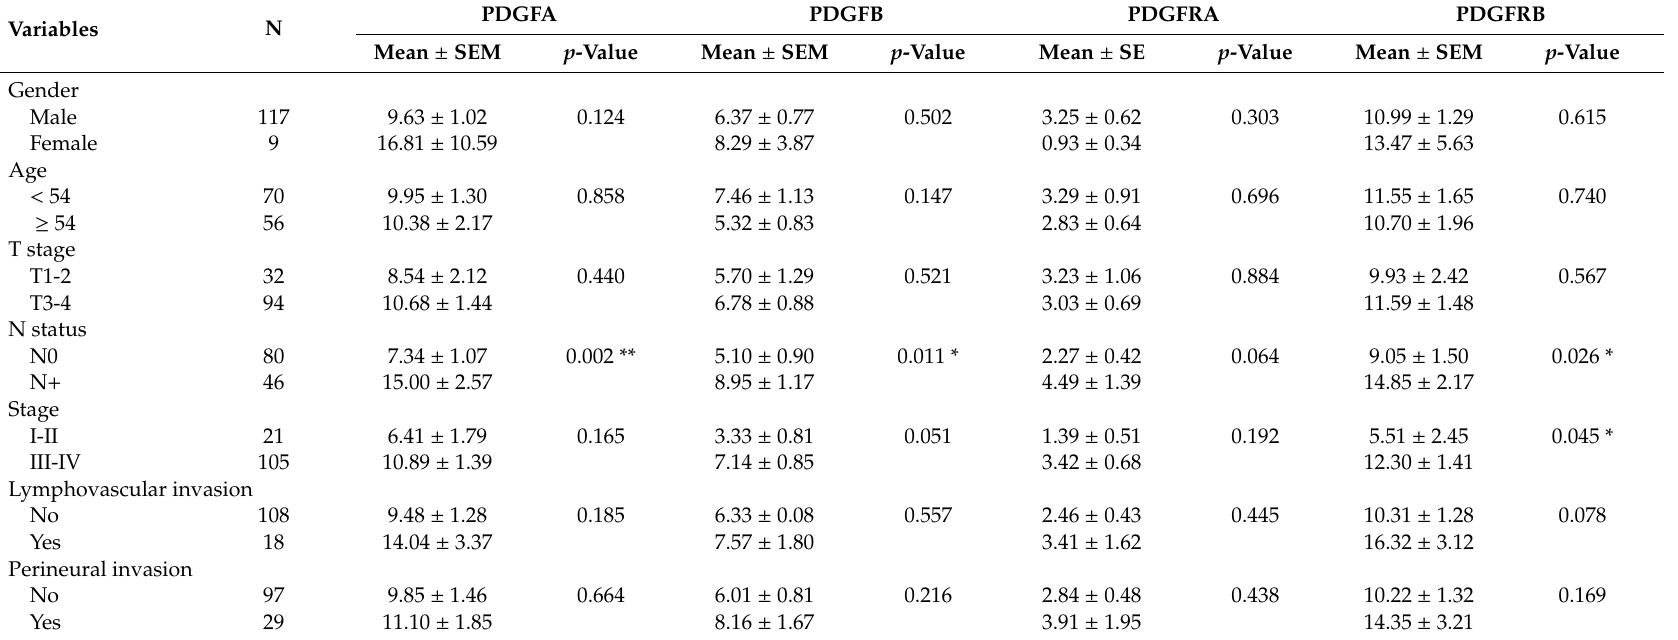
Table 1. Relationship between clinical parameters and mRNA expression of PDGF and PDGFR in OSCC